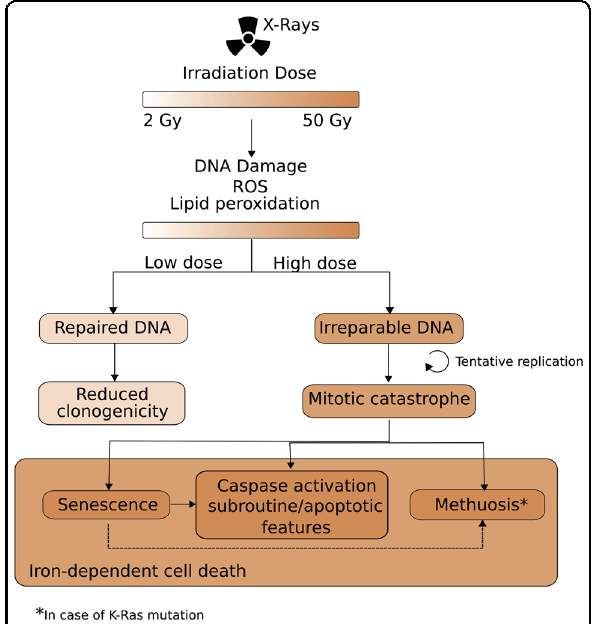
Fig. 8 Cellular responses to ionizing radiation. Following X-ray irradiation with doses ranging from 2 to 50 Gy, there is a dose- dependent increase in ROS production, lipid peroxidation, and DNA damage. As a result, the DNA damage response is activated and will attempt to resolve the DNA breaks. In a case of low irradiation dose (<10Gy), cells manage to repair their DNA, and still retain their capacity to proliferate. Cells with irreparable DNA that go into replication will be stuck in the mitotic cycle and undergo mitotic failure. Cells in a state of mitotic catastrophe will have several fates depending on the extent of the nuclear abnormalities and on the proteins expressed. Several outcomes of mitotic catastrophe seem to co-exist, such as senescence, methuosis, necrosis (membrane permeabilization), and activation of Bax, Bak, and caspases with presence of apoptotic features. A part of the senescent cells might become apoptotic (dotted arrow). K-Ras mutation can induce both senescence and methuosis; however, a link between the two cell states was never described. Here, we found that part of the large cells with fl attened morphology also had methuotic vacuoles, which might indicate that methuosis could be an outcome of senescent cells (dotted arrow). Ultimately, the cells will die out of an iron-dependent type of cell